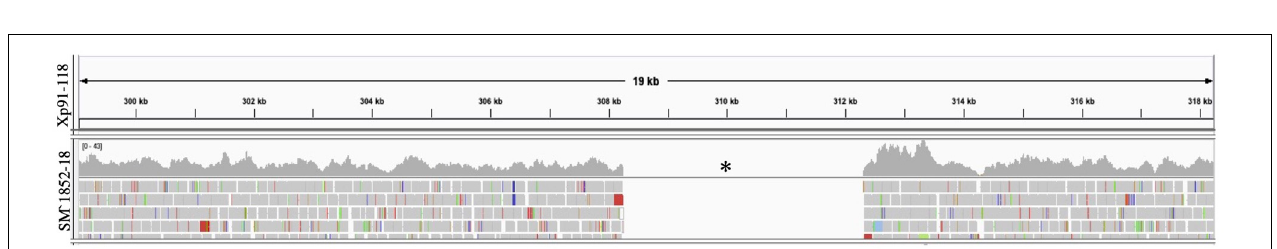
FIGURE 4 | Mapping of sequence reads to avrXv3 from Xp91-118. Burrows Wheeler Alignment was utilized to map reads from X. perforans isolate SM1852-18 to Xp91-118. Integrative Genome Viewer was utilized to visualize mapped reads. No reads (denoted with a black asterisk) from SM1852-18 mapped to Xp91-118.